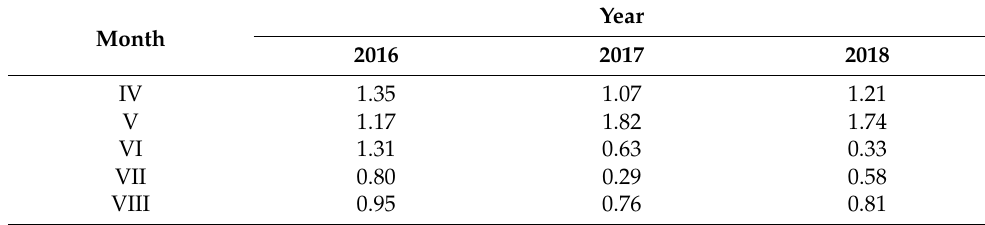
Table 5. Hydrothermal coefficient (K) during the growing seasons of spring